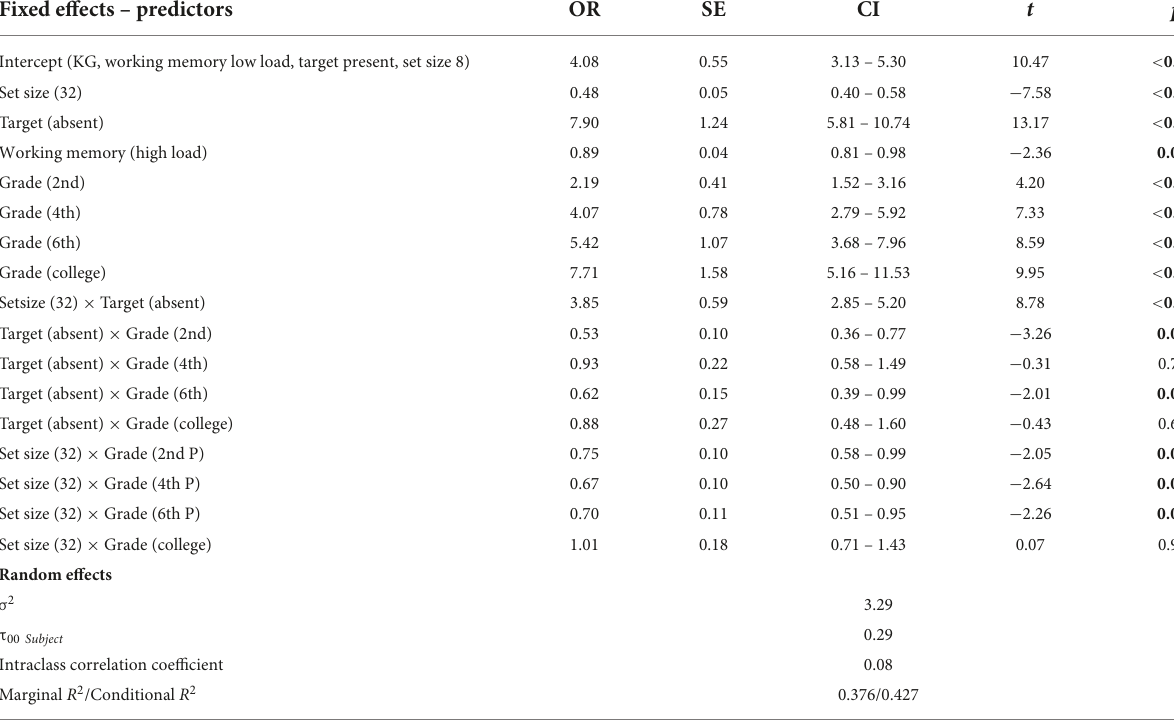
TABLE 2 Estimated coefficients for correct responses (odds ratios) in the visual search task. Fixed effects – predictors